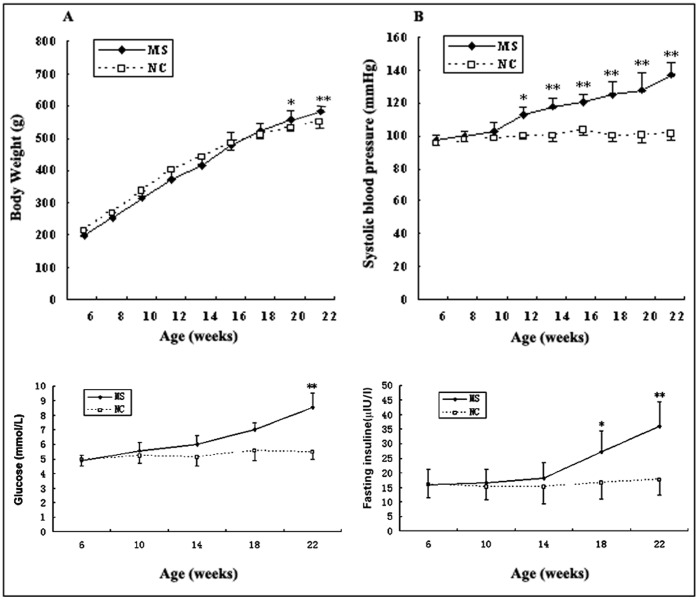
Body weight, systolic blood pressure, fasting blood glucose and fasting insuline were measured from 6 weeks to 22 weeks.Note a marked increase of body weight, systolic blood pressure, fasting blood glucose and fasting insuline from 20 wk, 12 wk, 22 wk and 18 wk, respectively. **P<0.01 vs. the normal-fed rats, *P<0.05 vs. the normal-fed rats.